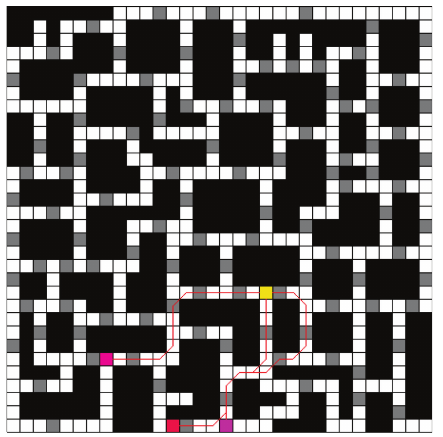
Figure 7: Path with overlapping